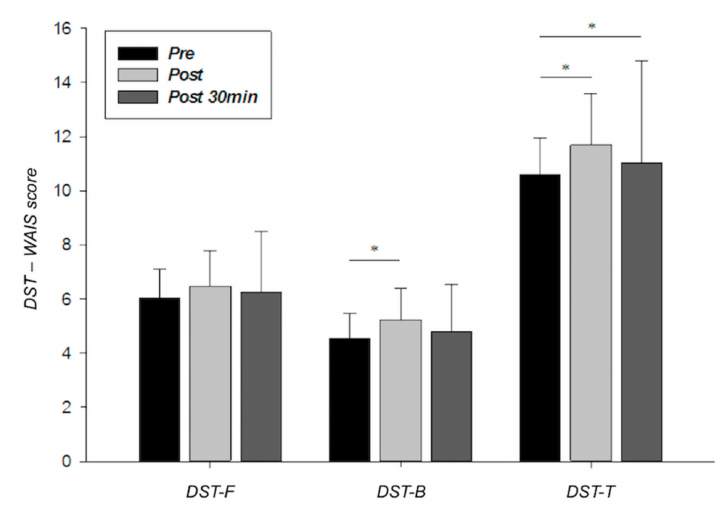
Figure 1. DST-F, DST-B, and DST-T scores measured at the intervention’s time-points (session 2). Error bars represent standard deviations. WAIS = Wechsler Adult Intelligence Scale; DST: Digit Span Test; DST-F = Digit Span Test in the forward condition; DST-B = Digit Span Test in the backward condition; DST-T = total Digit Spam Test score. * p < 0.05.